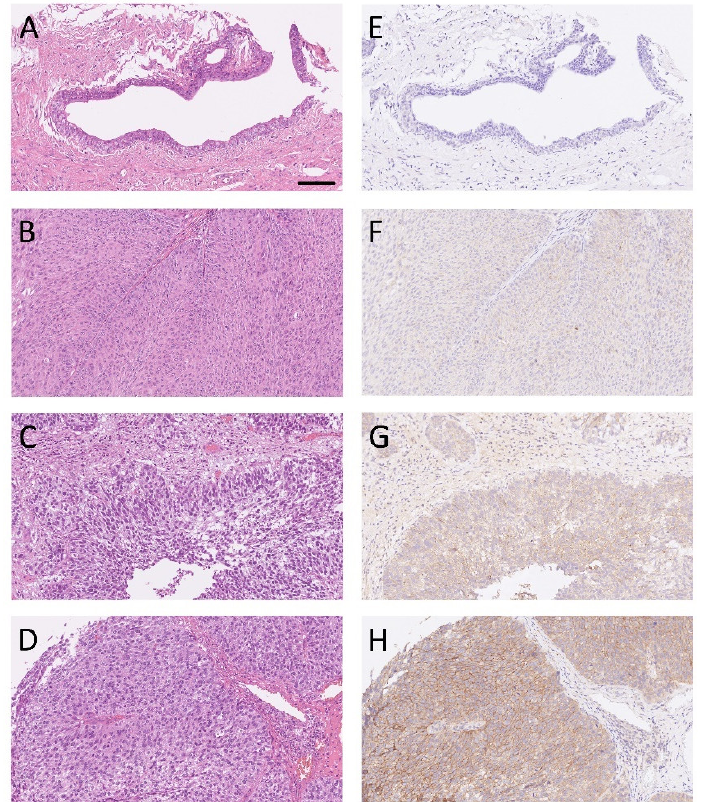
Figure 3. Representative sections of the normal urothelium ( A ), low-grade urothelial carcinoma (UC) ( B ), and high-grade UC ( C , D ) stained with H&E and immunostained for SERPINE2 ( E – H ). SERPINE2 immunoreactivity to the normal urothelium, low-grade UC, and high-grade UC was observed as ( E ) negative, ( F ) weak (1+), ( G ) moderate (2+), and ( H ) strong (3+). Scale bar in ( A ), 100 µm. The scale bar applies to all panels.